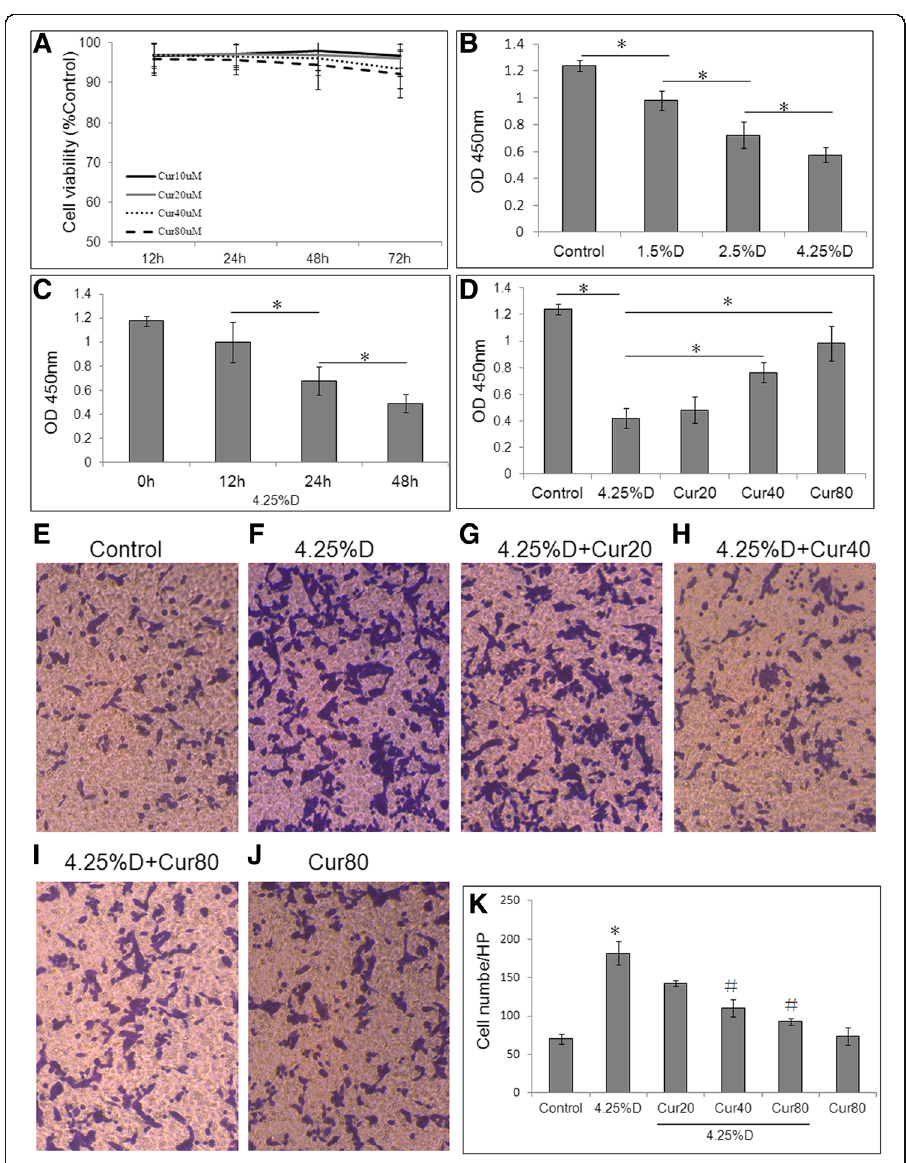
Fig. 1 Effect of curcumin on HMrSV5 cell viability and migration. Cells were treated with various concentrations of curcumin (10, 20, 40 and 80 μ M) for 12, 24, 48 and 72 h ( a ) or various concentrations of PDS (1.5% Dianeal, 2.5% Dianeal, 4.25% Dianeal) for 24 h ( b ) or PDS (4.25% Dianeal) for various times (0, 12, 24 and 48 h) ( c ). Cells were divided into control group (cells treated with DMEM/F12 medium containing 0.5%FBS), 4.25% Dianeal group, and 4.25% Dianeal + curcumin group (cells treated with 4.25% Dianeal and curcumin of 20, 40, and 80 μ M) ( d ). Cell viability was measured by CKK-8 assay. * P < 0.05. Effect of curcumin on HMrSV5 cell migration was determined by Transwell assay, and the migrating cells were detected by crystal violet staining ( e : control group; f : 4.25% Dianeal group; g : 4.25% Dianeal + curcumin 20 μ M; h : 4.25%D + curcumin 40 μ M; i : 4.25% Dianeal + curcumin 80 μ M; j : curcumin 80 μ M). Six random fields for each slice were counted, n = 3. * P < 0.05 vs. control group; # P < 0.05 vs. 4.25% Dianeal group k : The quantification of the migrating cells is expressed